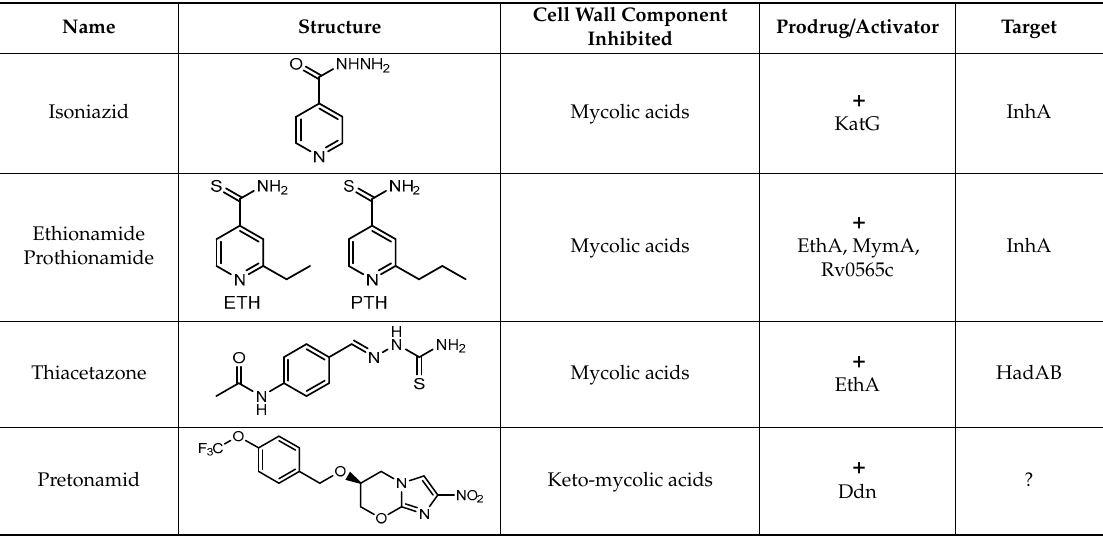
Table 1. TB drugs targeting the mycobacterial cell wall.